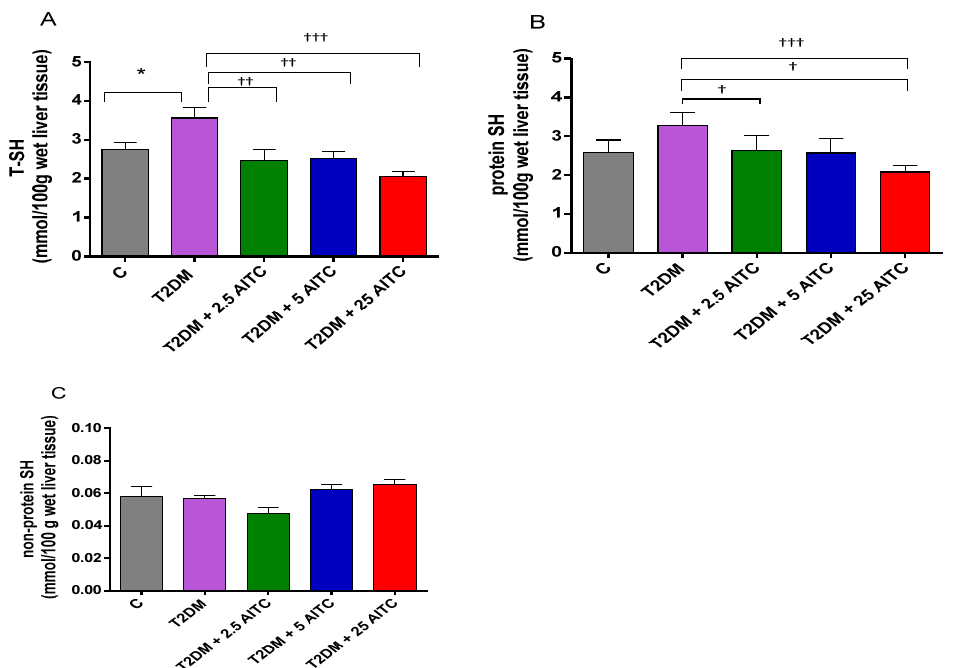
Figure 5. Effects of AITC on total-(T–SH) ( A ), protein-bound (PB–SH) ( B ), and nonprotein (NP–SH) ( C ) sulfhydryl groups content in the liver of diabetic rats. Each column represents the mean ± SEM ( n = 8). * p ≤ 0.05 compared with C group; † p ≤ 0.05, †† p ≤ 0.01, ††† p ≤ 0.001 compared with T2DM group. Abbreviations: C—control group; T2DM—high-fat diet with STZ-injected group; T2DM +AITC 2.5; AITC 5; AITC 25—high-fat diet with STZ-injected group with oral administration of 2.5; 5; 25 mg/kg b.w. AITC, respectively.